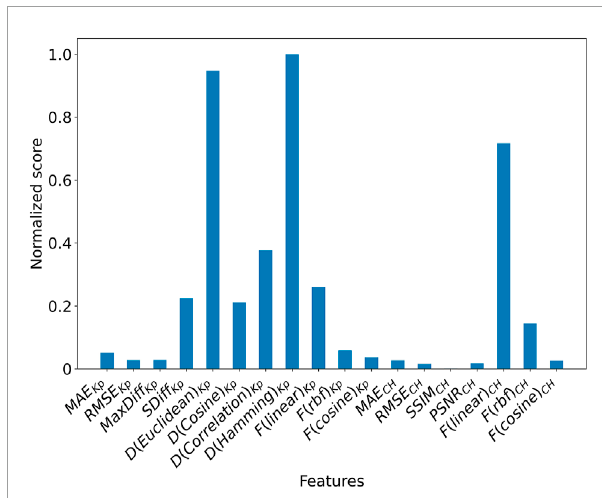
FIGURE 5 Scores of similarity of input pairs at the training dataset by feature